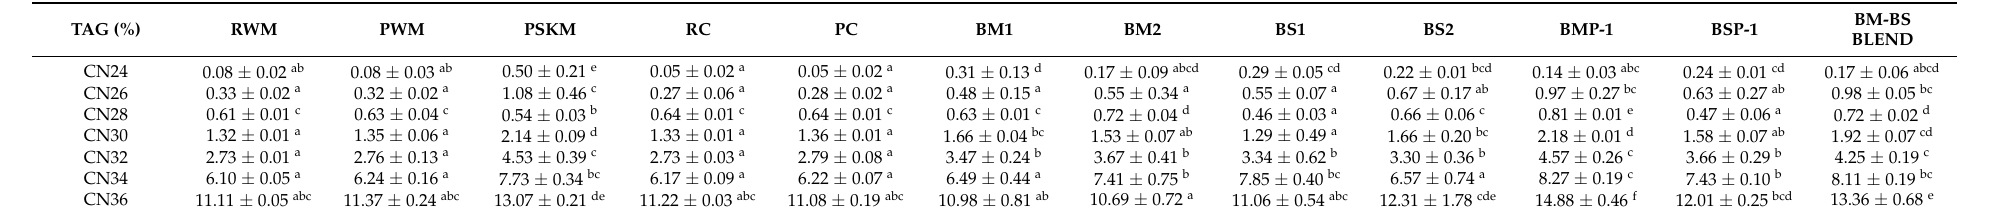
Table 3. Mean values of triacylglycerol (TAG) content of milk, cream and by-product samples of the butter and butter oil manufacturing